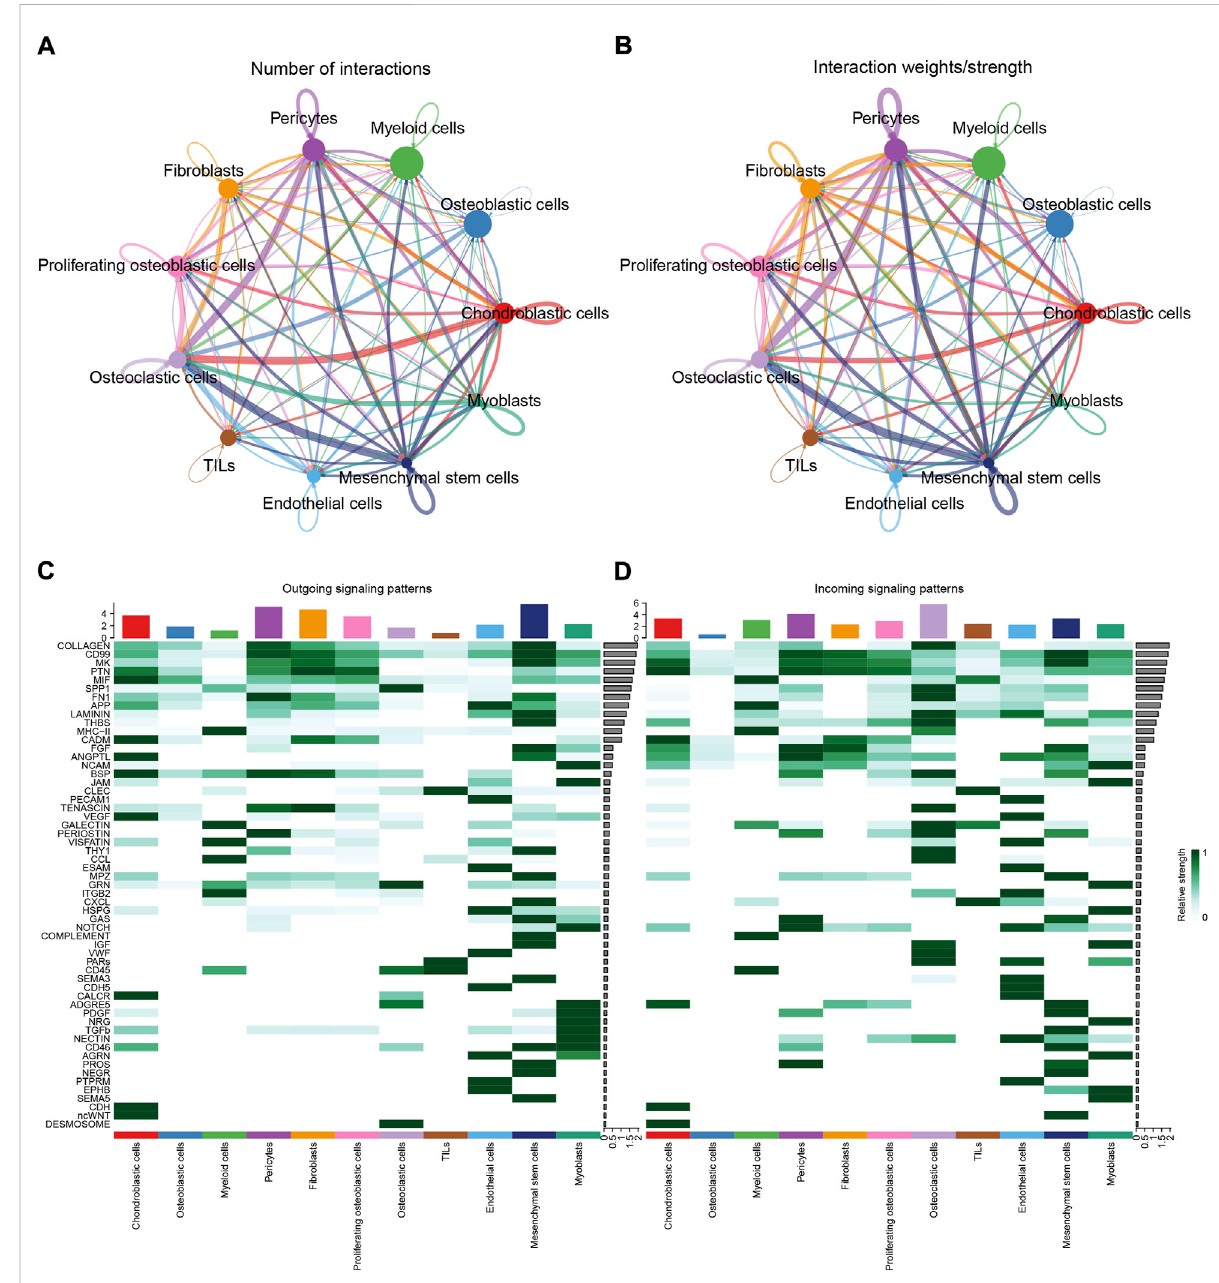
FIGURE 4 Cell – cellcommunicationnetworkamongdifferentcelltypes. (A,B) :thenumbersandweightsofligandreceptorsamongallcelltypes. (C,D) :the outgoing and incoming interaction strength among all cell